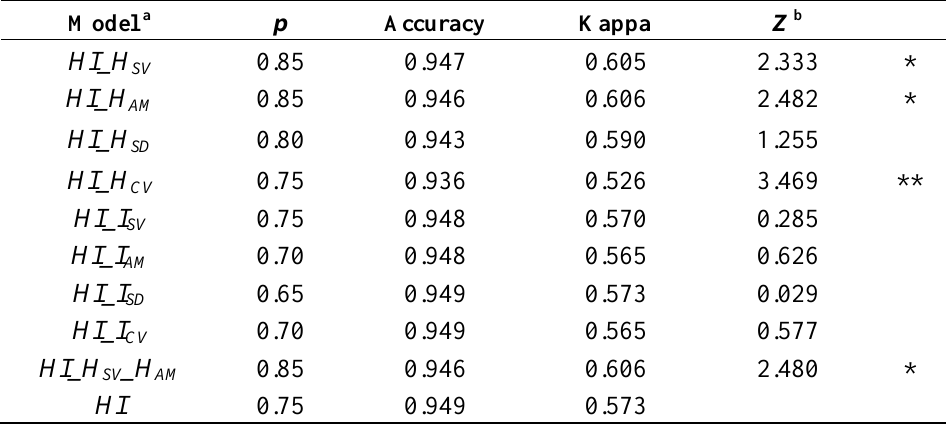
Table 5. Performance of the different models used for classification with